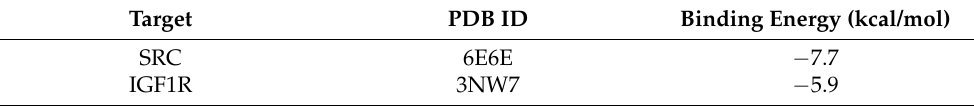
Figure 6. Molecular docking of costunolide with SRC and IGF1R. Table 2. Binding energies of costunolide with SRC and IGF1R.